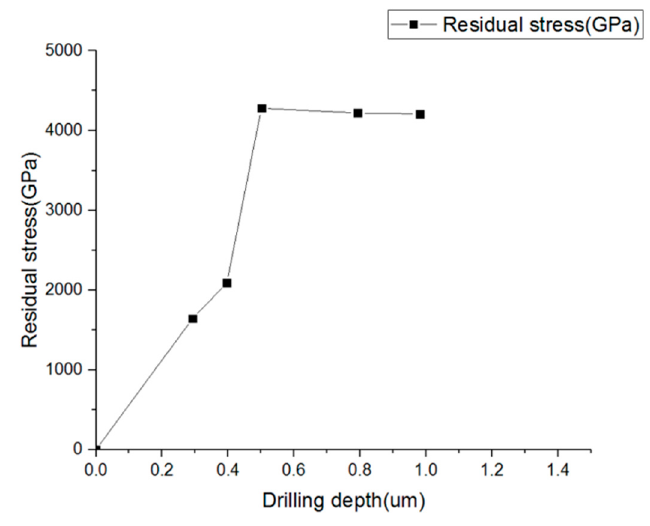
Figure 9. Relaxed residual stress measurement of ZrN of FIB-DIC. Table 5. The residual stress measurement results of ZrN thin films compared with the values obtained from the XRD of other